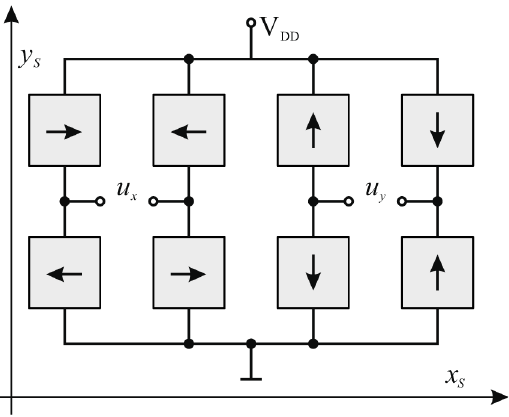
Figure 2. The structure of the measurement bridges within an MR angular sensor.